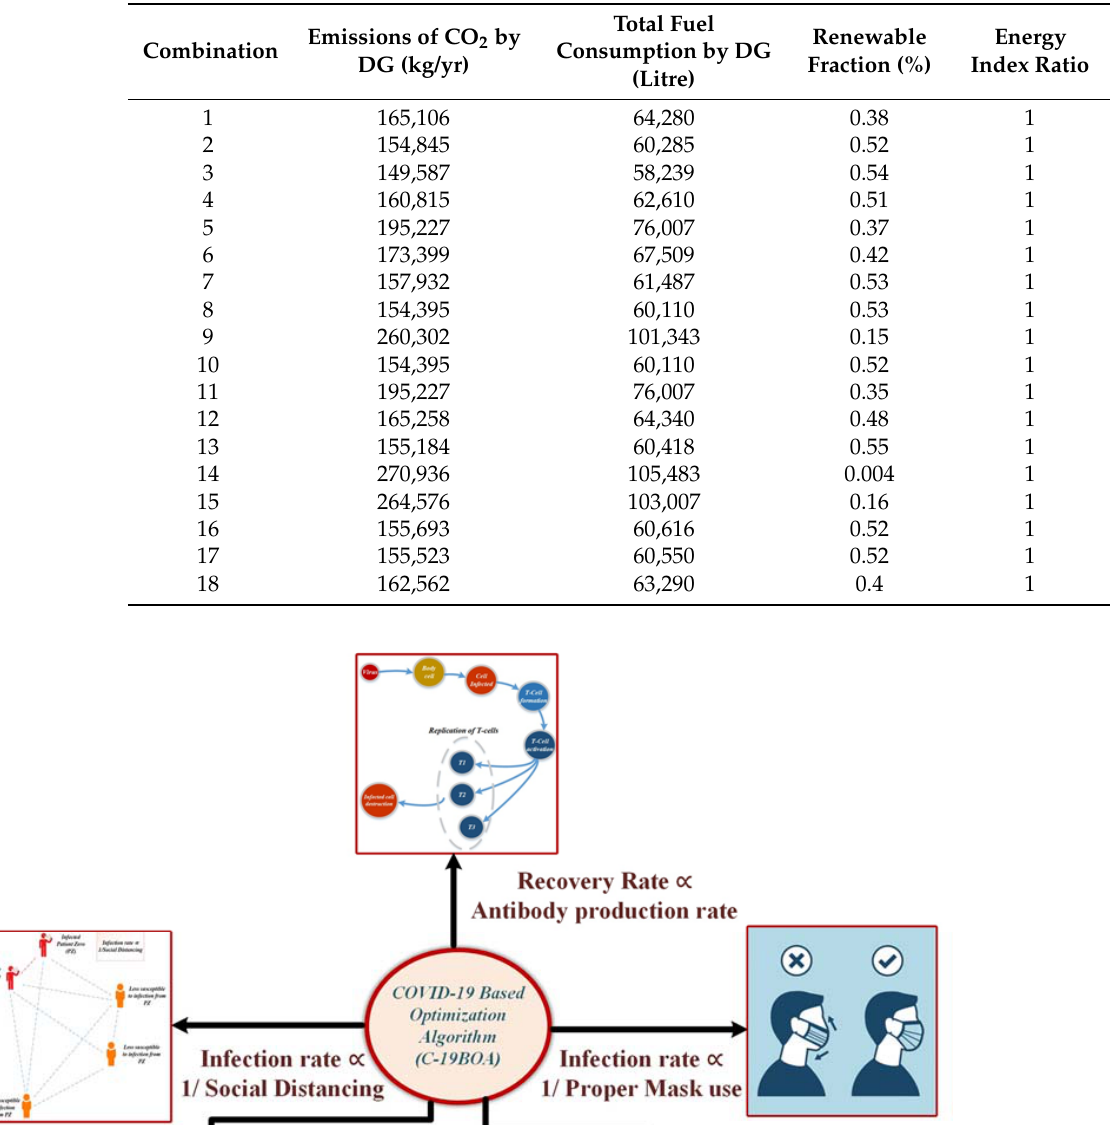
Table 2. Carbon emission, total fuel consumption and renewable fraction for each combination.